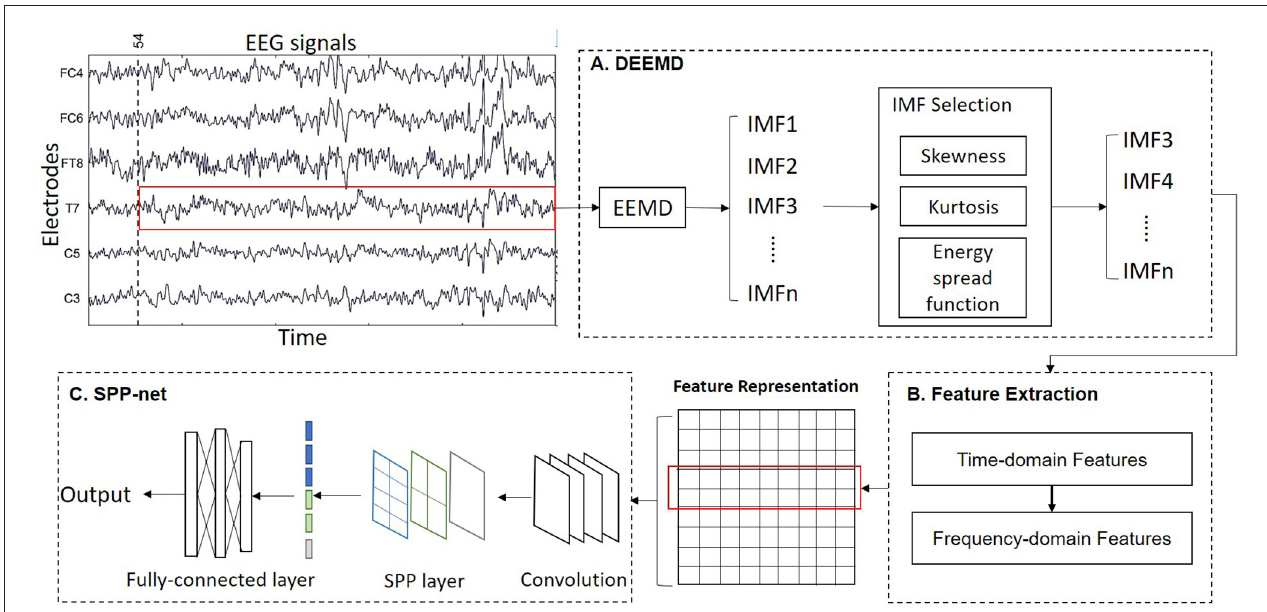
FIGURE 1 | Overall scheme of the DEEMD-SPP. (A) DEEMD algorithm for signal decomposition. (B) Feature extraction of IMFs. (C) SPP-net for emotion